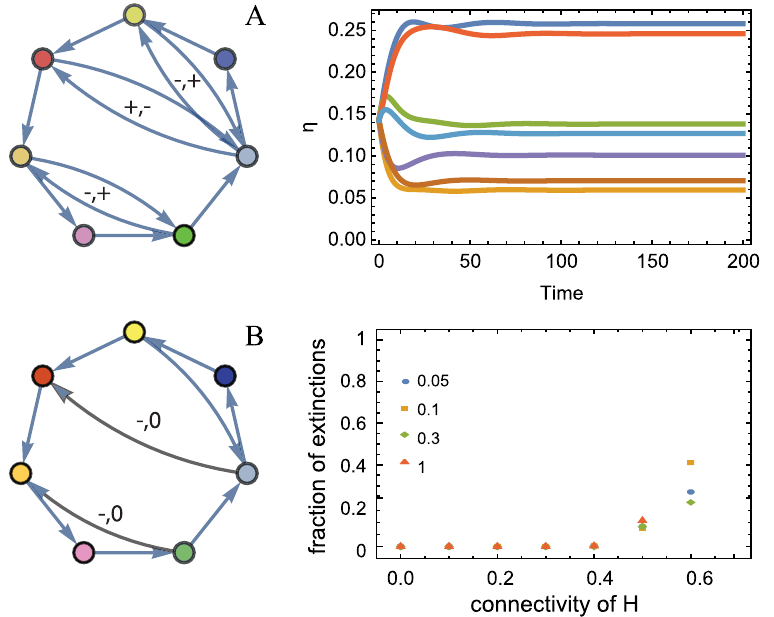
Figure 4. The fraction of extinctions of network with exploitative or harmful interactions as well as cooperative interactions. ( A ) Species interaction network for 7 species where each species i has one mutualistic partner j , i.e. M ij = 1, some species have exploitative interactions ( + − ) and cooperative and exploitative intensities are =  = 1. The corresponding time evolution of the populations of the 7 species, as predicted by the mean field  1 2 dynamics Eq. (2), are also shown. During the time evolution, the rates given by Eq. (1) remain positive and extinctions are not observed. ( B ) Example of a network with harmful interactions and plot of the fraction of extinctions (defined as the fraction of species extinct in the community) as a function of the connectivity of harmful matrix H ( c H ) and with connectivity of the cooperative matrix M ( c M = 1 − c H ) for different average interaction strengths (colored points) μ M = − μ H = 0.05, 0.1, 0.3, 1 (see legend) and cooperative and harmful  =  = 1. The off-diagonal elements of matrices M and H are drawn from normal distribution, intensities are 1 H i.e.